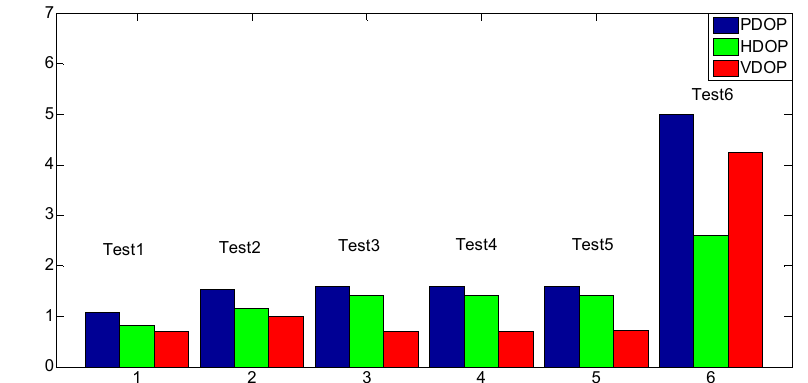
Figure 3. The frequency histograms of parameter estimator bias.